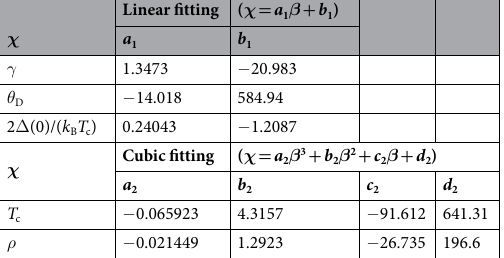
Table 1. Material parameters variation with Sn content β